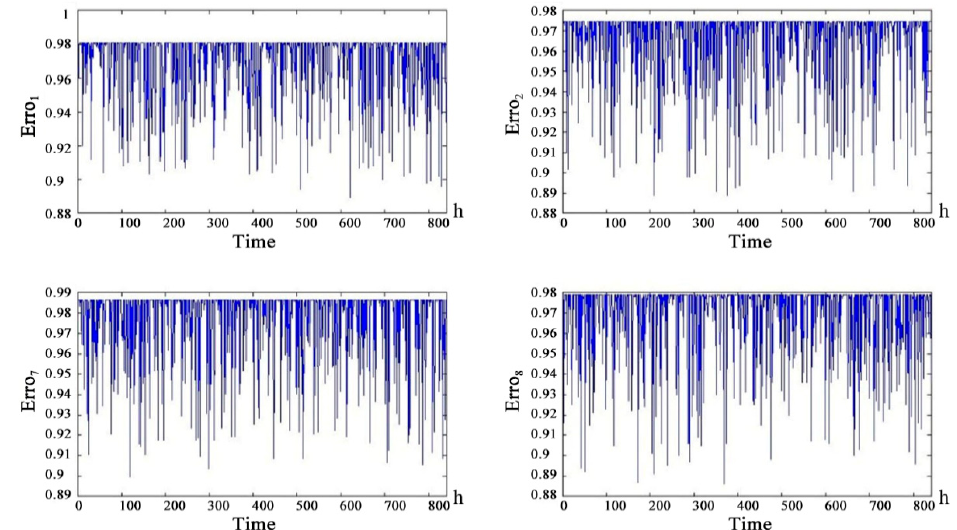
Figure 10. The health status probability of channel with constant communication distance.